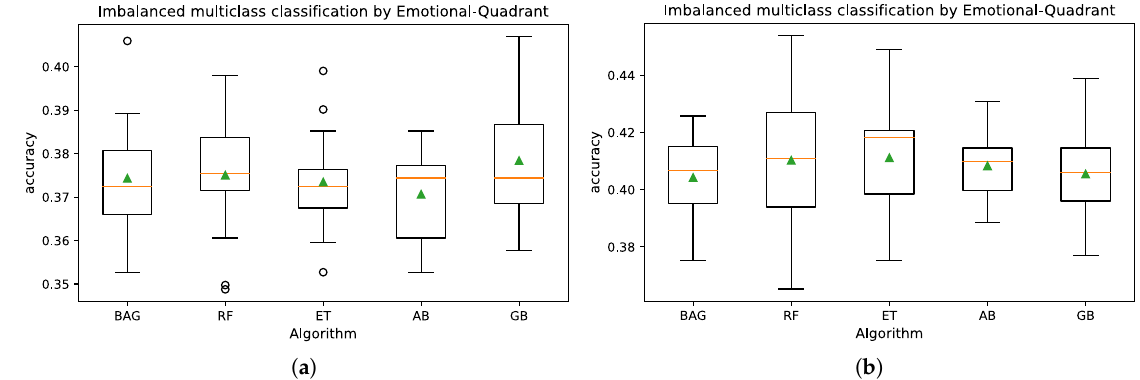
Figure 10. Multiclass classification for ES dataset of 30 HR instances: ( a ) with 60 s between instances; ( b ) with five seconds between instances.